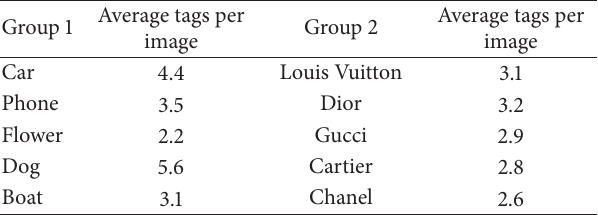
Table 2: The detailed information of the data